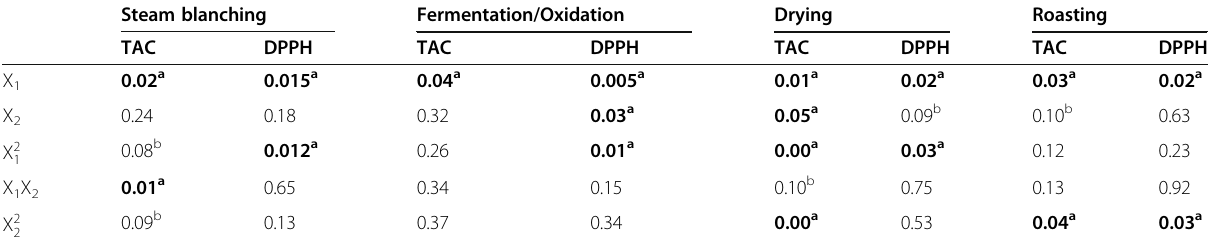
DPPH scavenging activity of fermented/oxidized leaves was negatively (Eqs. 7, 8) and significantly ( p < 0.05, Table 4) affected by the linear effects of time and temperature, whereas TAC was only significantly ( p < 0.05, Table 4) affected by the linear effect of temperature. Temperature had a greater effect on these variables compared to time. These negative coefficients indicate that both DPPH and TAC decrease with an in- crease in fermentation/oxidation time and temperature as illustrated in Fig. 1b. Maximal values for TAC were obtained at temperatures lower than 30 °C, whereas for DPPH scavenging activity maximal values were observed with Moringa leaves fermented at 25 – 35 °C for 15 to 35 min (Fig. 1b). Thus, the area represented by temperature Modelling and optimizing fermentation/oxidation of between 25 and 30 °C and oxidation time of 15 – 35 min Moringa leaves was found to be optimum (Fig. 1b) for TAC and DPPH. The effect of temperature and time of oxidation on both TAC and DPPH are represented in Eqs. 7 and 8. Modelling and optimizing drying of Moringa leaves To depict the mathematical relationship between the temperature and the time of drying on both TAC and DPPH scavenging activity, the experimental data were fitted into second order polynomial Eqs. 9 and 10. Table 4 ANOVA test ( P -value) of time and temperature of steam blanching, fermentation/Oxidation, drying and roasting on AOA in M. oleifera leaf extracts Steam blanching Fermentation/Oxidation Drying